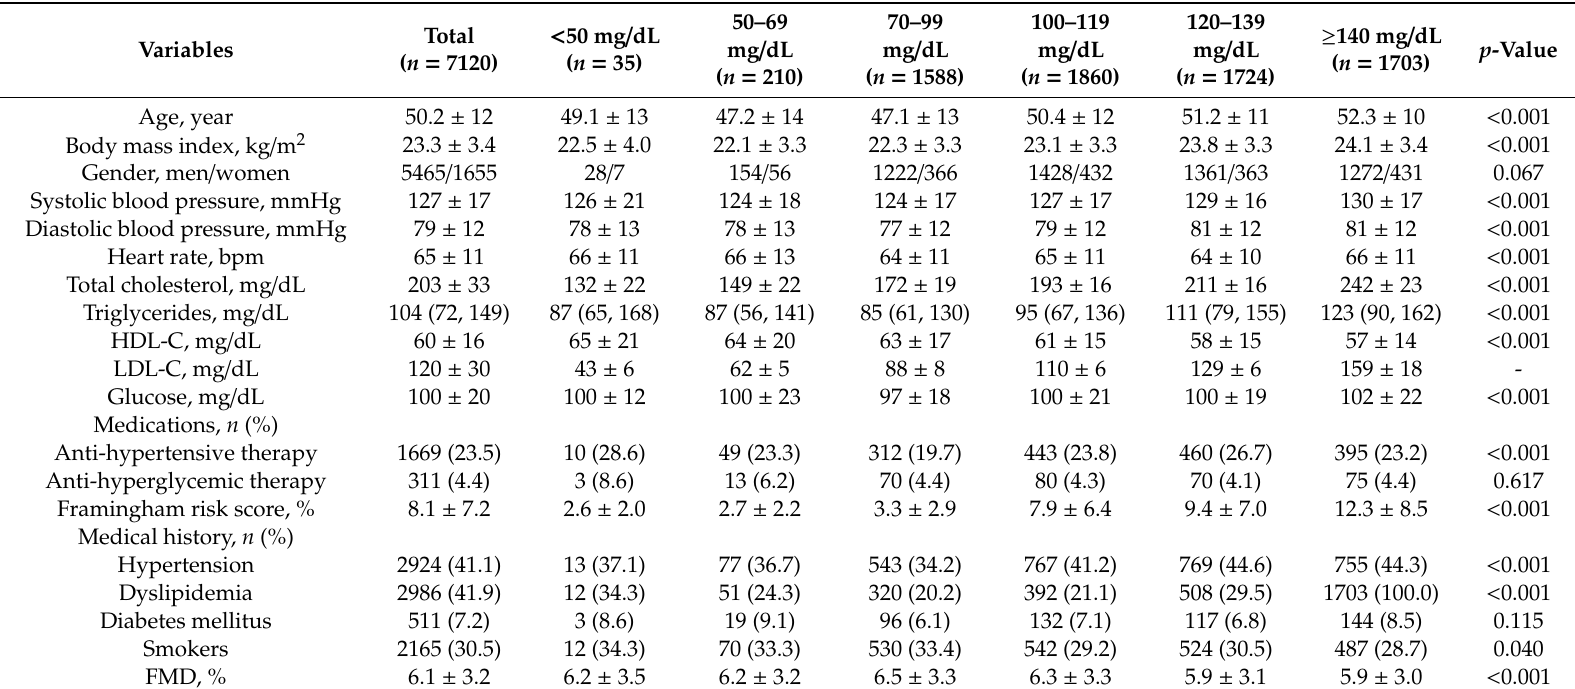
Table 4. Clinical characteristics of the subjects on the basis of